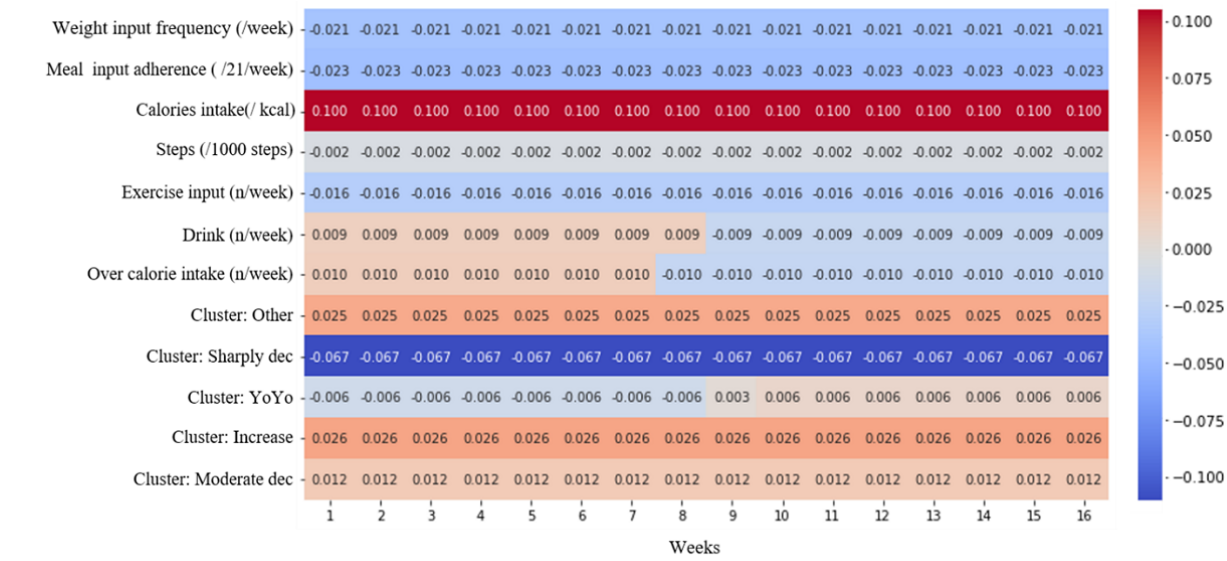
Figure 5. Contribution coefficients for predicting weight change in each week for each